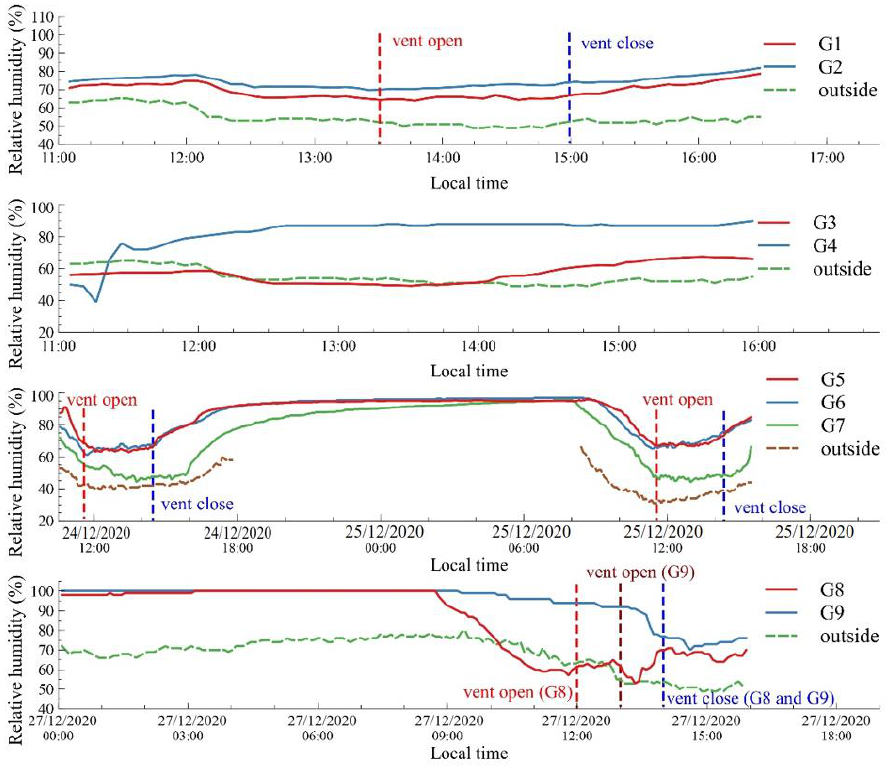
Figure 9. Relative humidity data of each greenhouse.